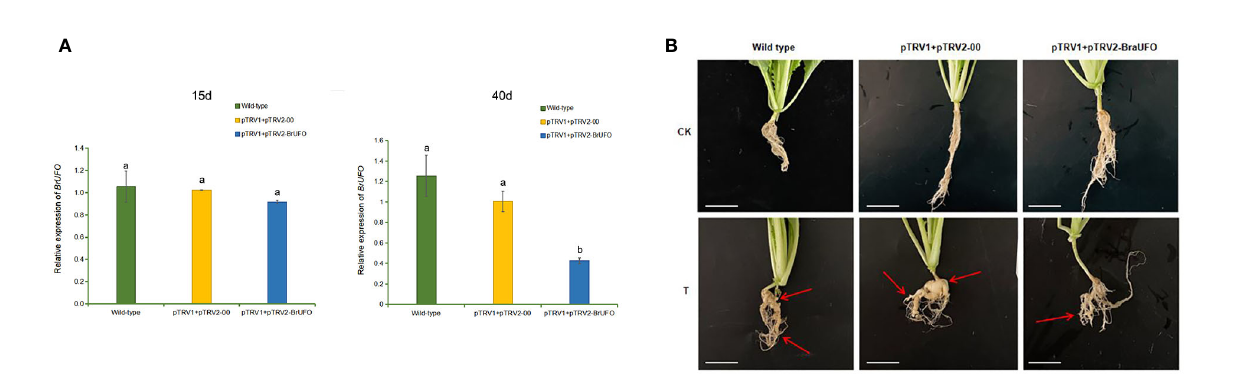
FIGURE 3 Functional validation of BrUFO in Chinese cabbage responses to infection by Plasmodiophora brassicae. (A) Expression of BrUFO in the roots of Chinese cabbage after VIGS treatment. Results are mean ± standard deviation (n = 3). Each set of data represents the mean of its three replicates, and the error line represents the standard deviation of its three replicates. Letters indicate signi fi cant differences at p ≤ 0.05 according to Duncan ’ s multiple range test. (B) Symptoms of clubroot disease in VIGS-treated roots on day 40 after VIGS treatment. CK, control plants not inoculated with P. brassicae ; T, plants treated with P. brassicae. On the 40 th day after VIGS treatment (i.e. the 25 th day after inoculation with P. brassicae ), obvious clubroot symptoms were showed on the taproots and fi brous roots of both control plants. To pTRV1+pTRV2- BrUFO plants, only mild swelling symptoms were evident on the fi brous roots, but not on taproots. Scale bar=2